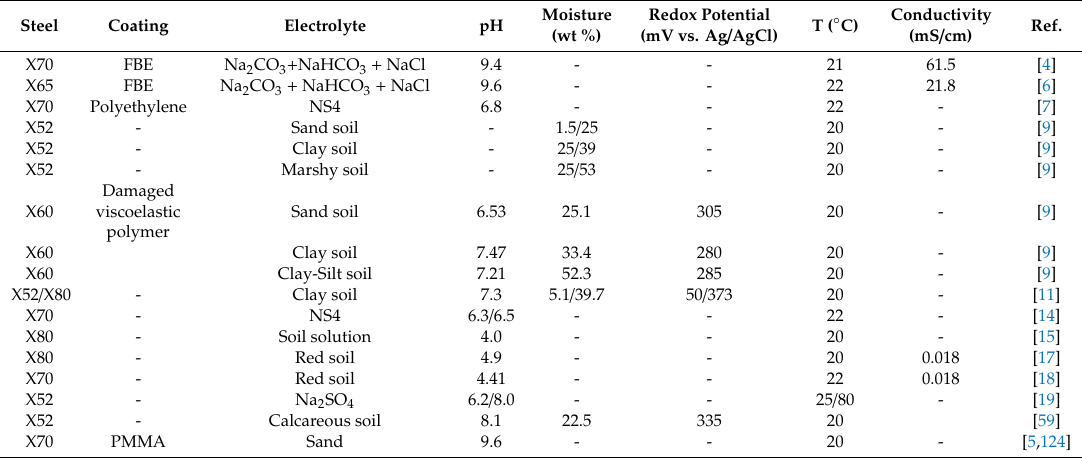
Table 2. Reviewed physicochemical properties for external corrosion studies.